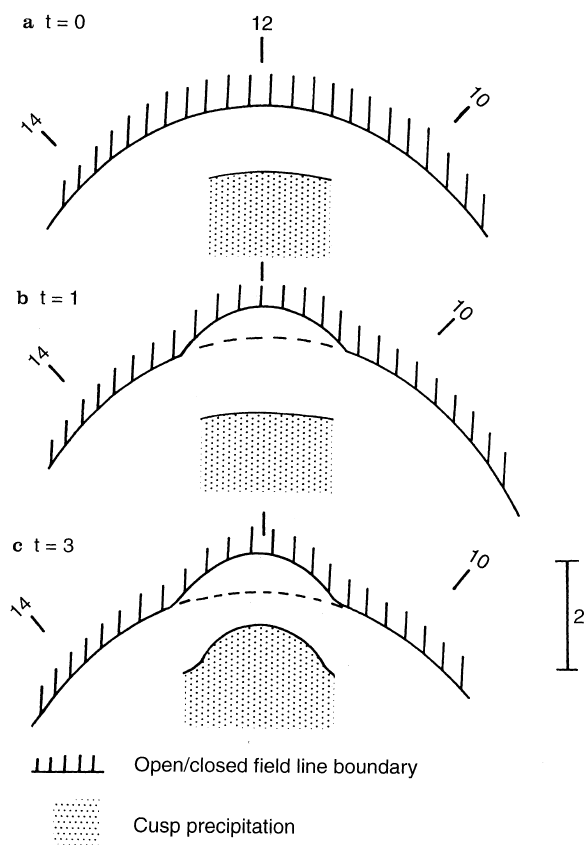
Fig. 1 a–c. Schematic diagram showing the relationship between the ionospheric footprint of the open/closed field line boundary, marked by poleward edge of the 557.7 nm emission ( hatched area ), and the location of the 630 nm emission caused by cusp like energetic particle precipitation ( stippled area ). a is for ‘steady state’ conditions, t (cid:136) 0, b as a but for a few 10s of seconds after reconnection at the equatorial plane has been enhanced, and c for t (cid:136) 3 minutes after enhanced reconnection has occurred in the equatorial plane, and the associated Alfve´ n wave has arrived at the ionosphere. Assumptions made in constructing this figure are explained in